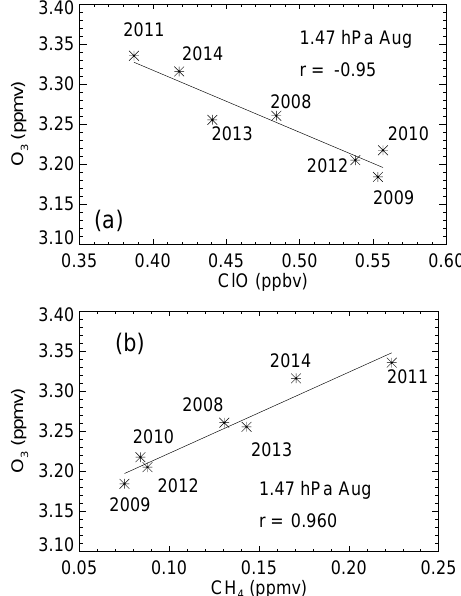
Figure 9. Scatter plot of August monthly mean MLS O 3 vs. (a) MLS ClO and (b) SOFIE CH 4 at 1.47hPa. The latitudes are near 78 ◦ N, corresponding to the latitude of the SOFIE occultations in August.